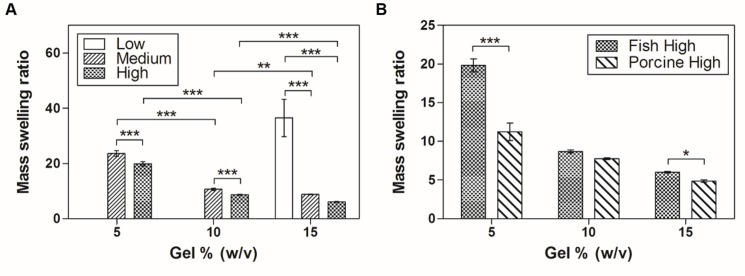
Equilibrium swelling properties of GelMA hydrogels.(A) The mass swelling ratios of fish GelMA hydrogels containing 5%, 10% and 15% (w/v) GelMA and low, medium and high degrees of methacrylation were significantly different (*p<0.05, **p<0.01, ***p<0.001). GelMA (5% and 10% (w/v)) with low methacrylation produced hydrogels which were too weak to be handled and therefore were not tested. (B) Comparison of fish and porcine GelMA hydrogels with a high degree of methacrylation. Error bars represent SDs of measurements of five samples.